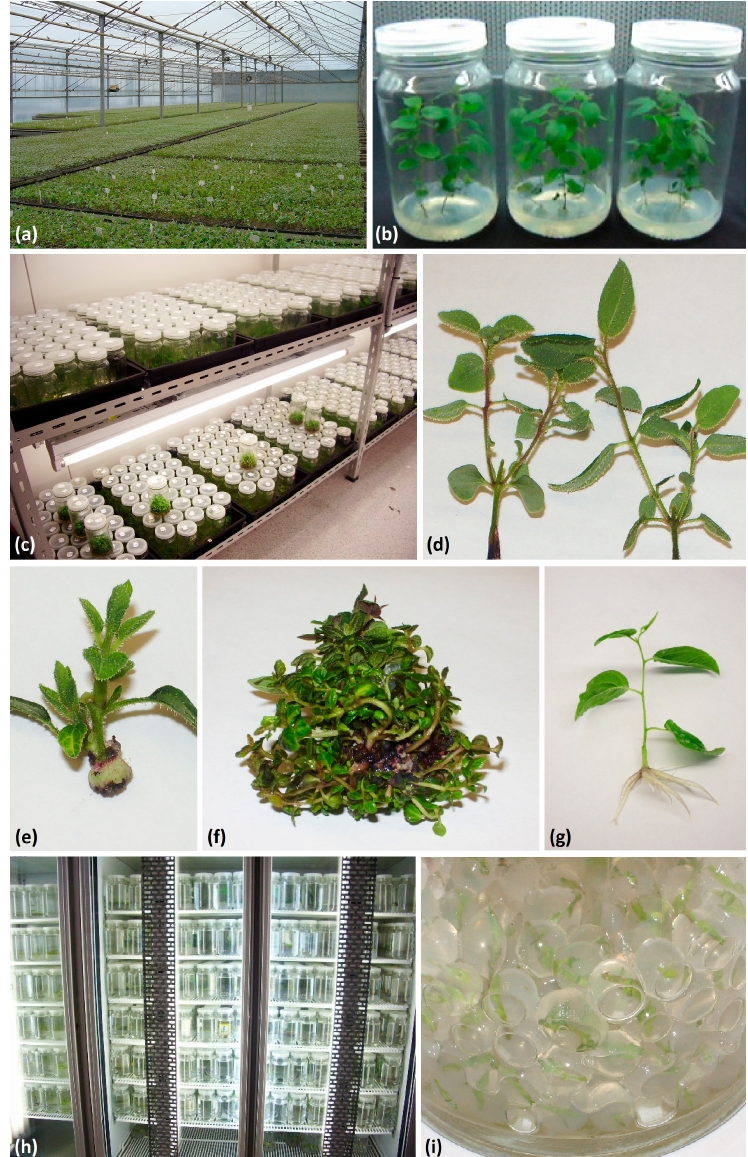
Figure 1. Eucalypt propagation and germplasm preservation: ( a ) Eucalyptus grandis × E. urophylla cuttings in a commercial nursery; ( b – i ) Corymbia torelliana × C. citriodora : ( b , c ) shoots in tissue culture; ( d ) axillary bud outgrowth in shoot culture; ( e ) callogenesis at the base of a shoot; ( f ) multiple shoot production in organogenic culture; ( g ) a plantlet; i.e., a shoot with adventitious roots; ( h ) shoots in cool storage; and ( i ) alginate-encapsulated shoot tips and nodes; i.e., synthetic seeds. Photographs: ( a ) I. Wendling, ( b , h ) S.J. Trueman, and ( c – g , i ) C.D. Hung.